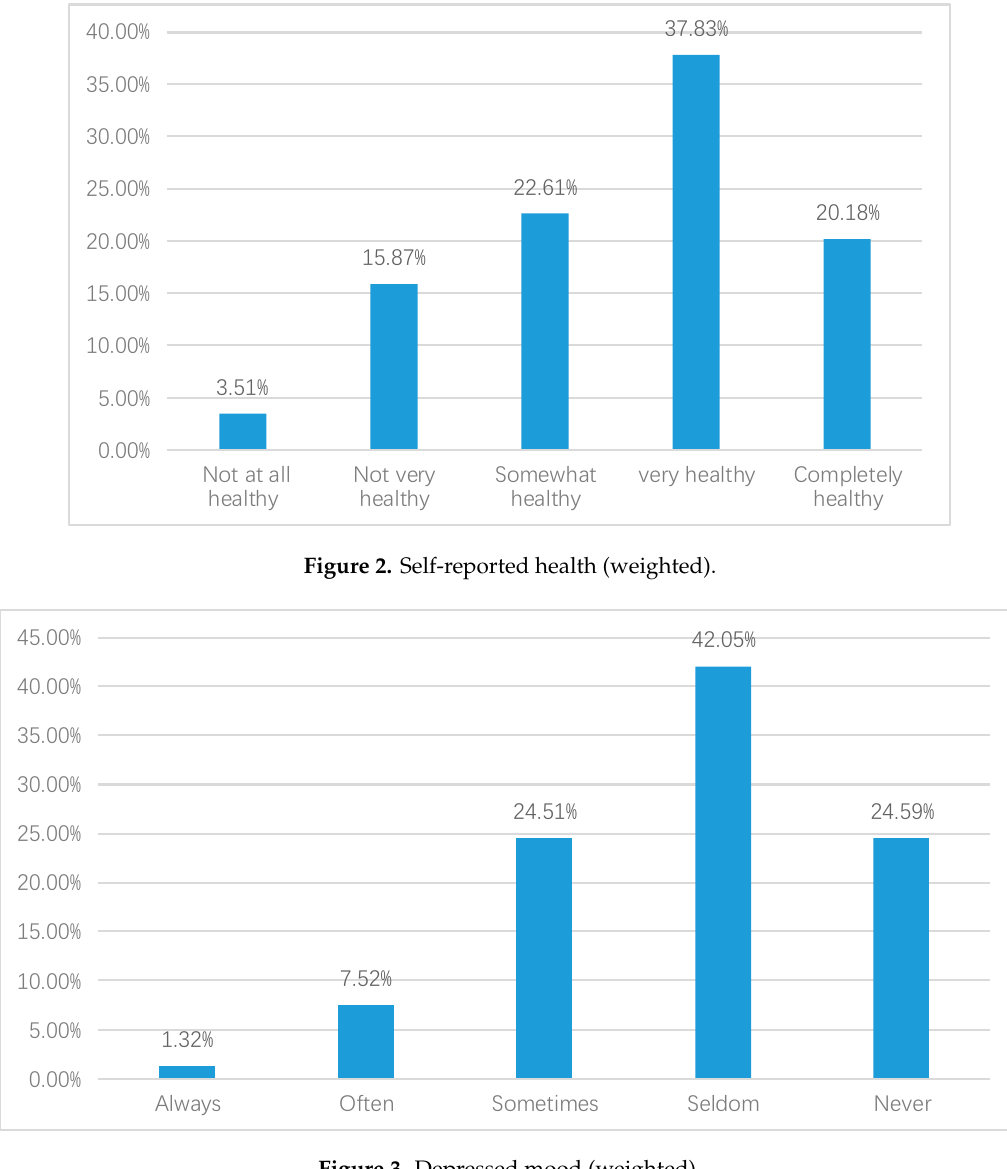
Figure 3. Depressed mood (weighted).